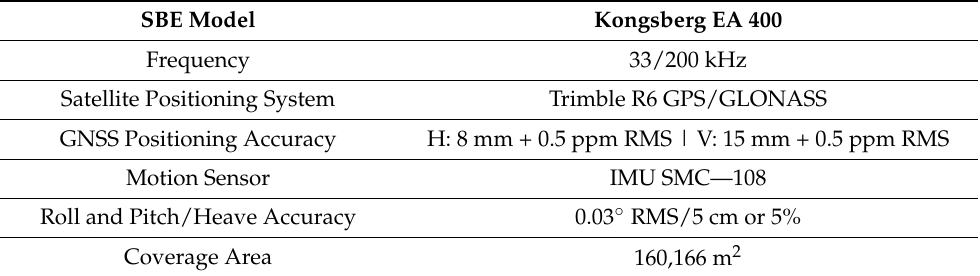
Table 2. SBES parameters and basic data associated with bathymetric data processing.